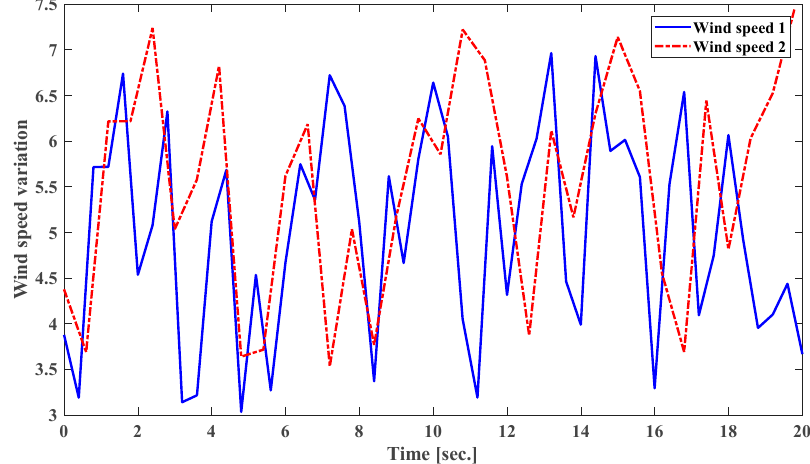
Figure 17. Wind speed variation.